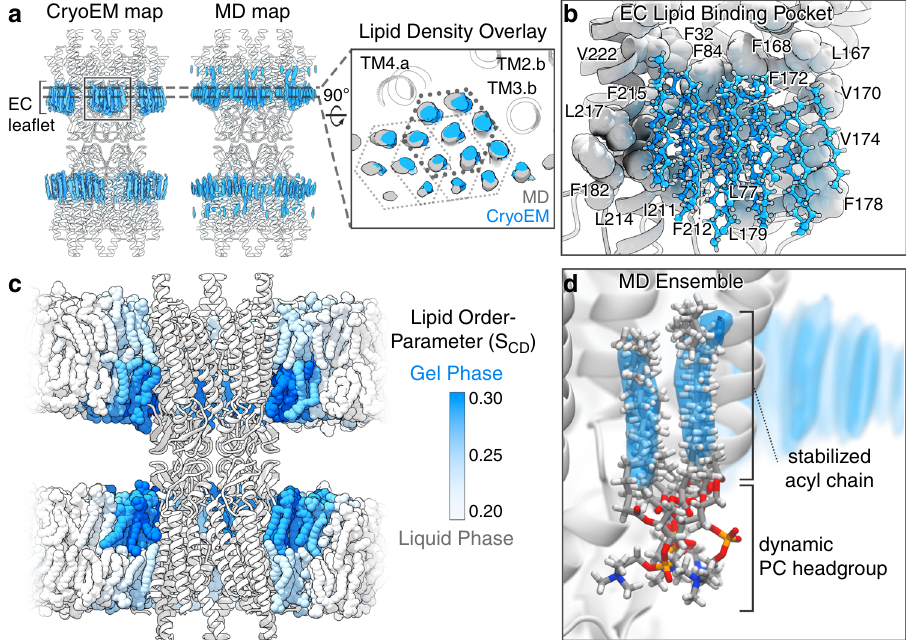
Fig. 3 Cx46/50 induces a local phase separation to the extracellular lipid lea fl et. a Comparison of acyl-lipid density maps (blue) obtained by CryoEM and time-averaged all-atom MD simulation, overlaid onto the Cx46/50 ribbon structure (white). Inset shows a slice view (rotated 90°) of overlaid acyl- lipid densities by CryoEM (blue) and MD simulation (gray). The hexagonal packing pattern of acyl chains is indicated (solid and dotted lines) and TM helices interacting with lipid are labeled. Different subunits are indicated by suf fi x ( a or b ). b Zoom view of the acyl-lipid-binding pocket, with lipid-binding residues displayed (spheres) and labeled (Cx50 numbering). c MD snapshot of Cx50 in phosphatidylcholine (PC) lipid bilayers, with time-averaged lipid order parameter ( S CD ) for each lipid indicated by shading (blue = 0.30 to white = 0.20). d Zoom view, showing an ensemble super-positioning of symmetry-related lipids obtained by MD simulation (displayed as all-atom representation, C = gray, H = white, O = red, N = blue, P = orange) occupying the MD-based lipid acyl-chain density map